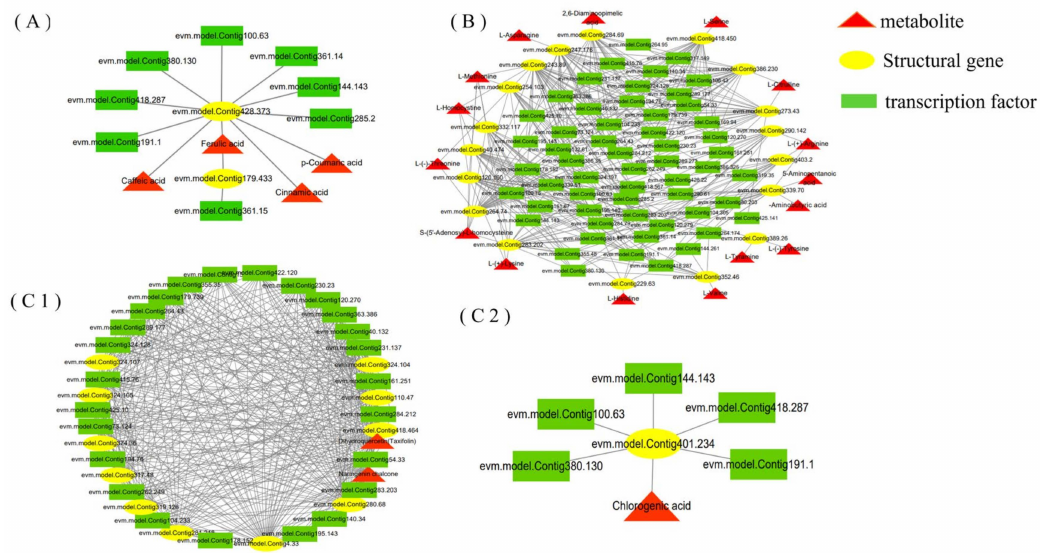
Figure 8. Regulatory network of amino acid, phenolic acid, and flavonol derivative biosynthesis. ( A ) The regulatory correlation between the characteristic metabolites of the phenolic acid pathway and structural genes and transcription factors. ( B ) The regulatory correlation of the amino acid pathway. ( C1 ) The regulatory correlation of the flavonoid pathway (naringenin chalcone and